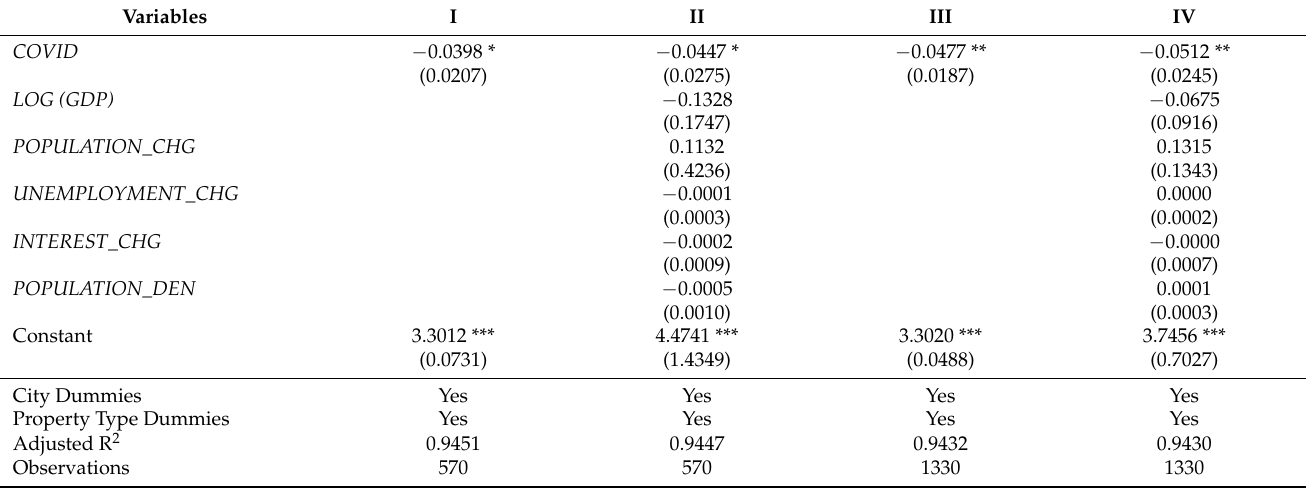
Table 8. Robustness Analysis on Alternative Sample Periods. This table presents the OLS regression estimation results of testing the impact of the COVID-19 pandemic on commercial real estate rent. The dependent variable is LOG (RENT) , the natural logarithm of rent for the specific city and property type. The independent variables of interest is COVID . In the first two columns, we restrict our sample to the year of 2019 before the COVID-19 pandemic to the second quarter of 2020. In the last two columns, we restrict our sample to the period of 2017 to the second quarter of 2020. All variables are described in Appendix A. The standard errors are reported in parentheses. ***, **, and * denote significance of the t-statistics at the <1%, 5% and 10% levels,